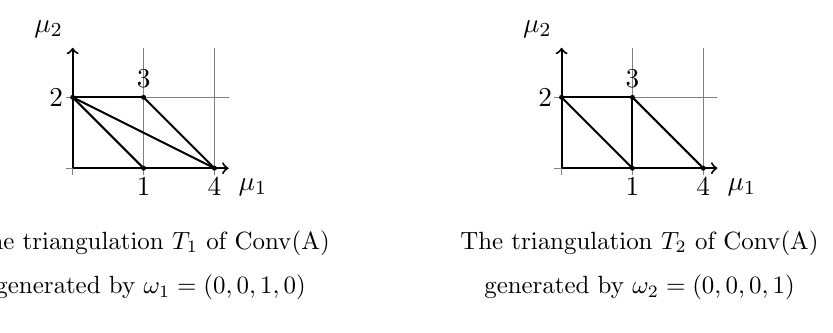
Figure 2 . The two possible regular triangulations of the Newton polytope (cid:1) G = Conv(A) corre- sponding to the Lee-Pomeransky polynomial G = z 1 x 1 + z 2 x 2 + z 3 x 1 x 2 + z 4 x 2